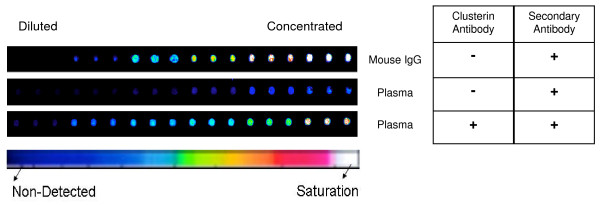
Scanned image of fragments of RPPMs showing spotted triplicates of plasma and mouse IgGs probed with (+) or without (-) primary anti-clusterin antibody, and with secondary fluorescently labeled anti-IgG antibody. Pseudo-color scale, dark blue to white corresponds to increasing fluorescence.